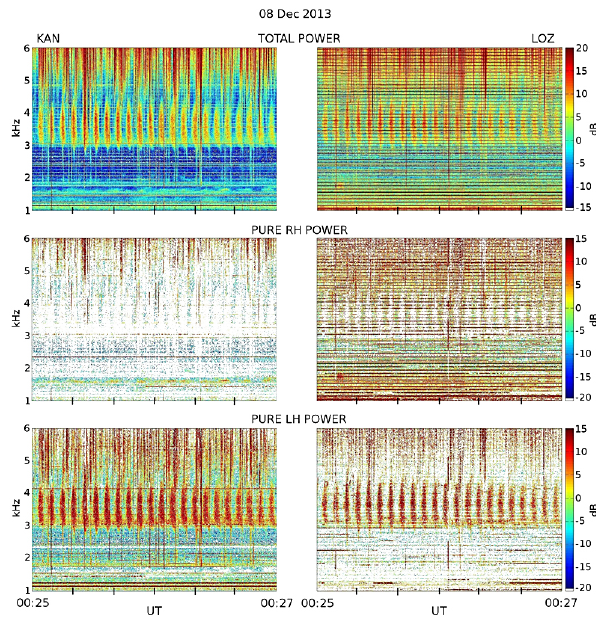
Figure 3. Dynamic spectra of left-hand polarized PE emissions ob- served at KAN and LOZ at 00:25–00:27UT on 8 December 2013.